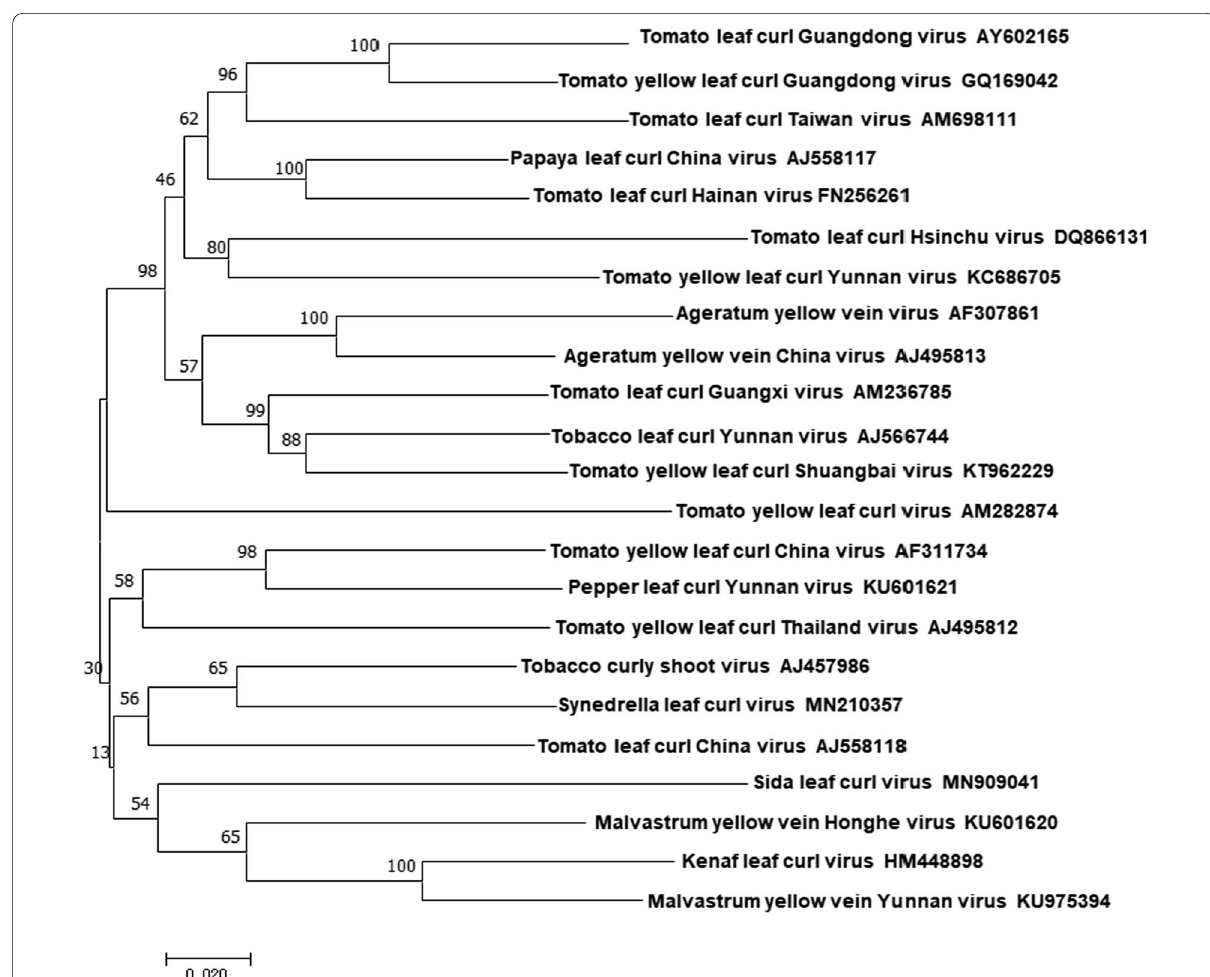
Fig. 2 Phylogenetic tree based on the full-length nucleic acid sequences of the geminivirus species from China that can infect tomato in the field. Numbers on the nodes suggest the percentage of bootstrap support from 1000